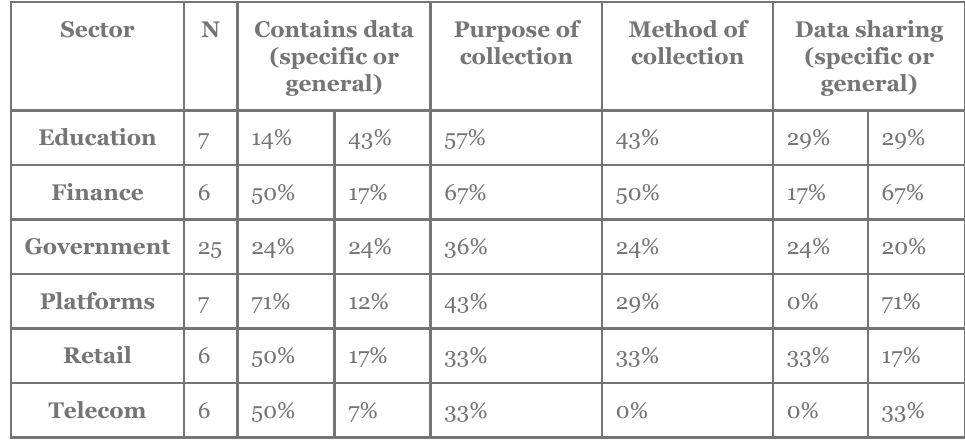
Table 3: Completeness of access responses, based on the elements specified in the law